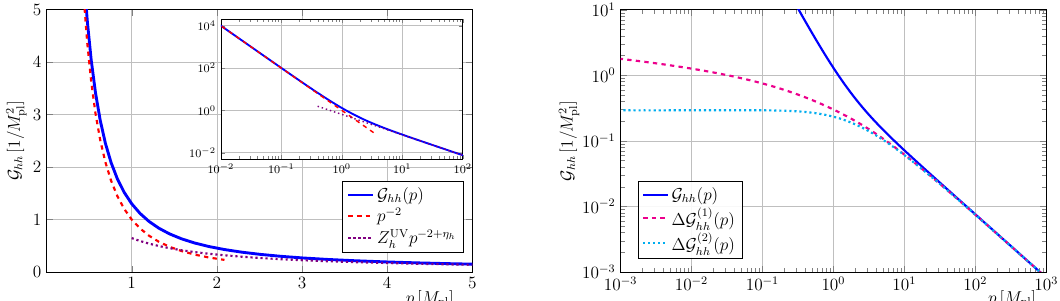
Figure 3: Momentum dependence of the Euclidean fluctuation graviton propagator ( p ) . (left) Momentum dependence of the Euclidean fluctuation graviton propagator G hh (blue, solid) with its IR and UV asymptotics. The UV asymptotic (violet, dotted) is = 1.03 and Z UV = 0.64, see (25). The IR asymptotic p − 2 + η h with η given by Z UV h h h (red, dashed) is simply the classical dispersion 1 / p 2 . (right) Subleading contributions ( 1 ) at small momenta in comparison to the full propagator (blue, solid). ∆ (magenta, hh G ( 2 ) dashed) carries a subleading log-like contribution, while ∆ (cyan, dotted) carries hh G a constant contribution for small